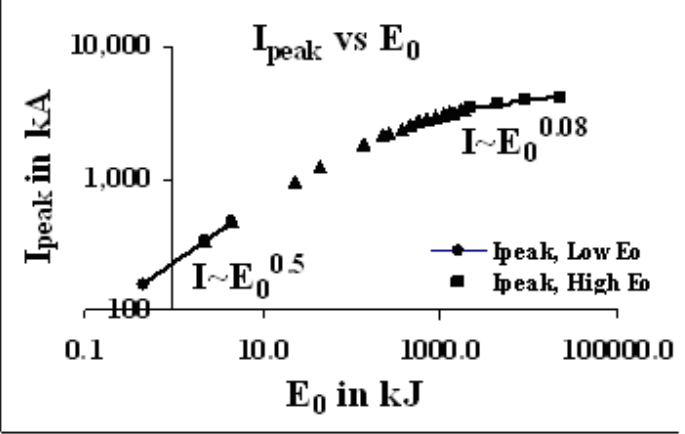
versus E on log-log scale, illustrating I peak 0